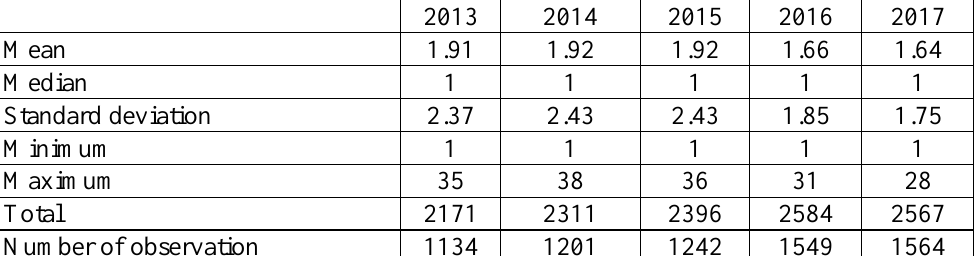
Table1. descriptive statistics of research variable in the research